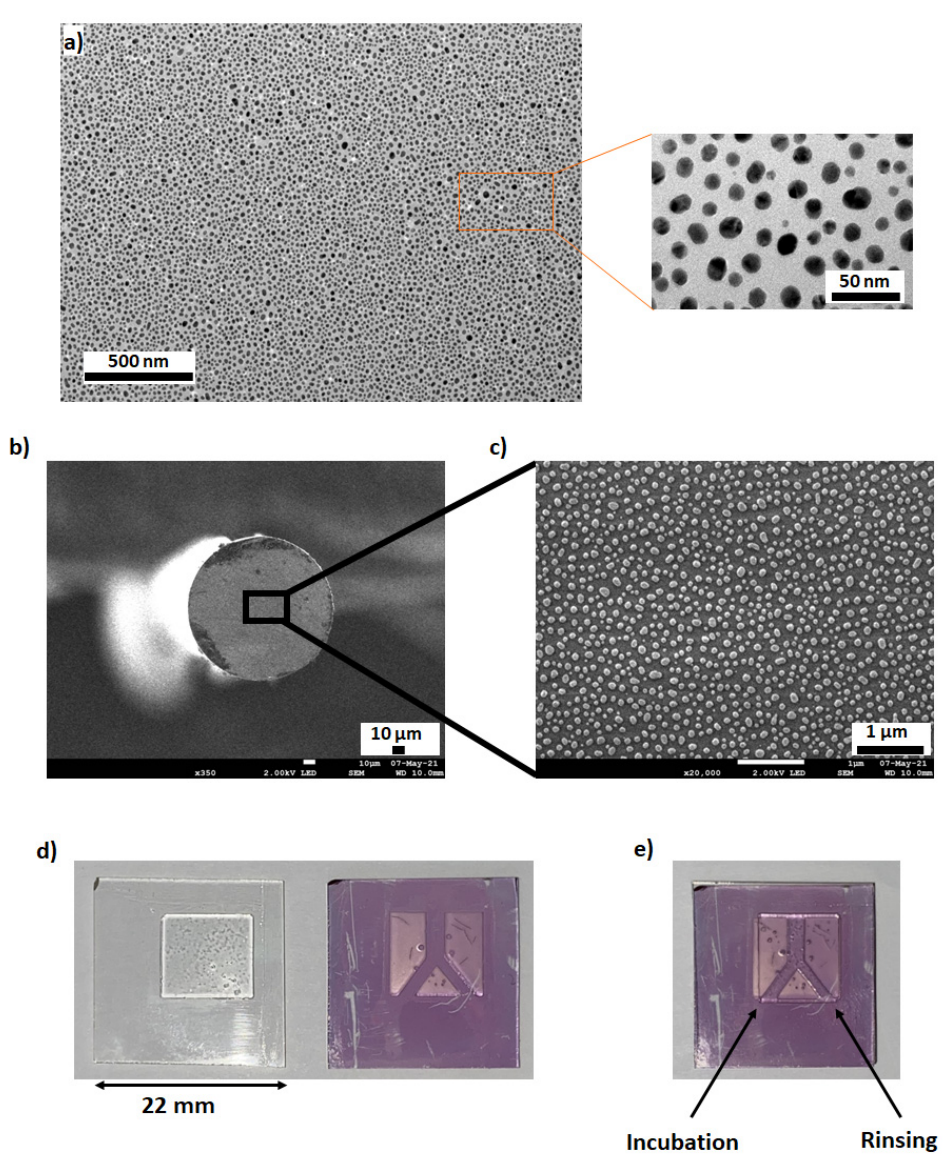
Figure 2. ( a ): TEM image of AuNPs synthesized by thermal dewetting from a 4 nm gold film on a glass substrate at 400 °C for 1 h, ( b ): synthesis of AuNPs by thermal wetting at the end of a 780 HP optical fiber of 125 µm diameter, ( c ): zoom on the optical fiber, ( d ): integration of a fluidic circuit on an AuNPs substrate by 3D printing ( right ) and its cover ( left ), ( e ): sealing of the fluidic circuit by live photopolymerization, the arrows indicate the rinsing and incubation circuits.